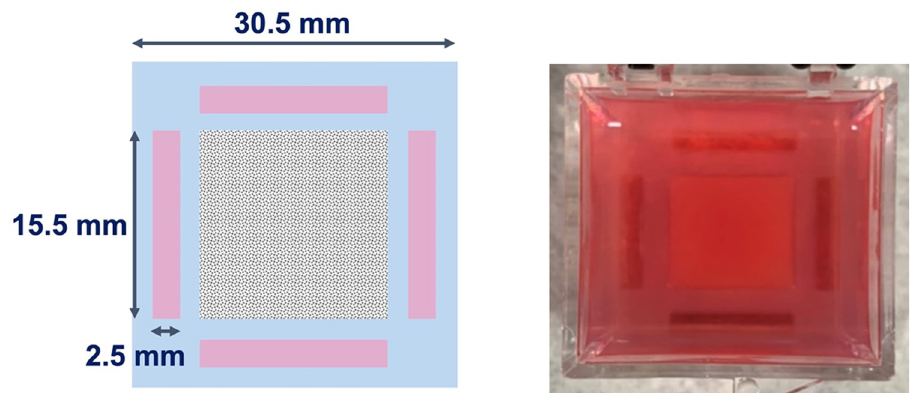
Fig 2. Top view of the sample and the agarose supporting structure (blue) along with side channels (pink) reserved for cell culture experiments.